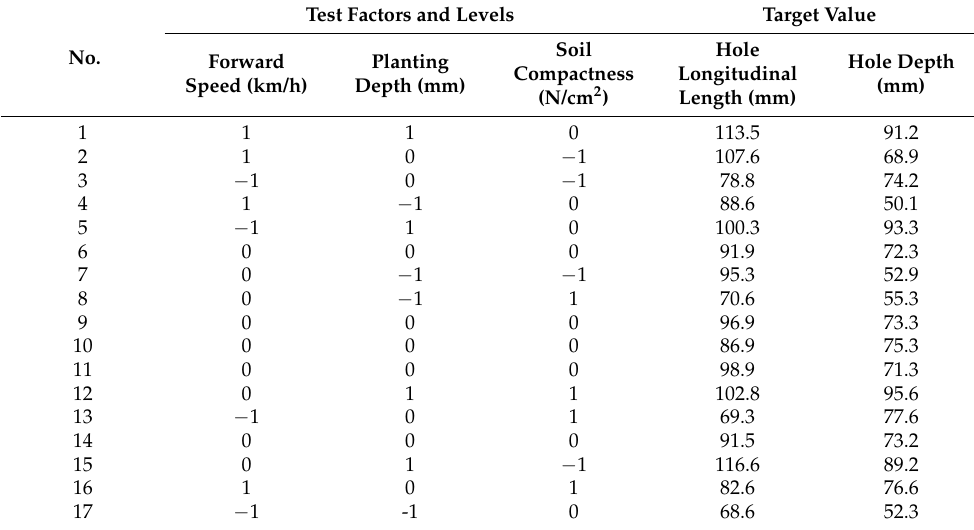
Table 5. Test design and results.